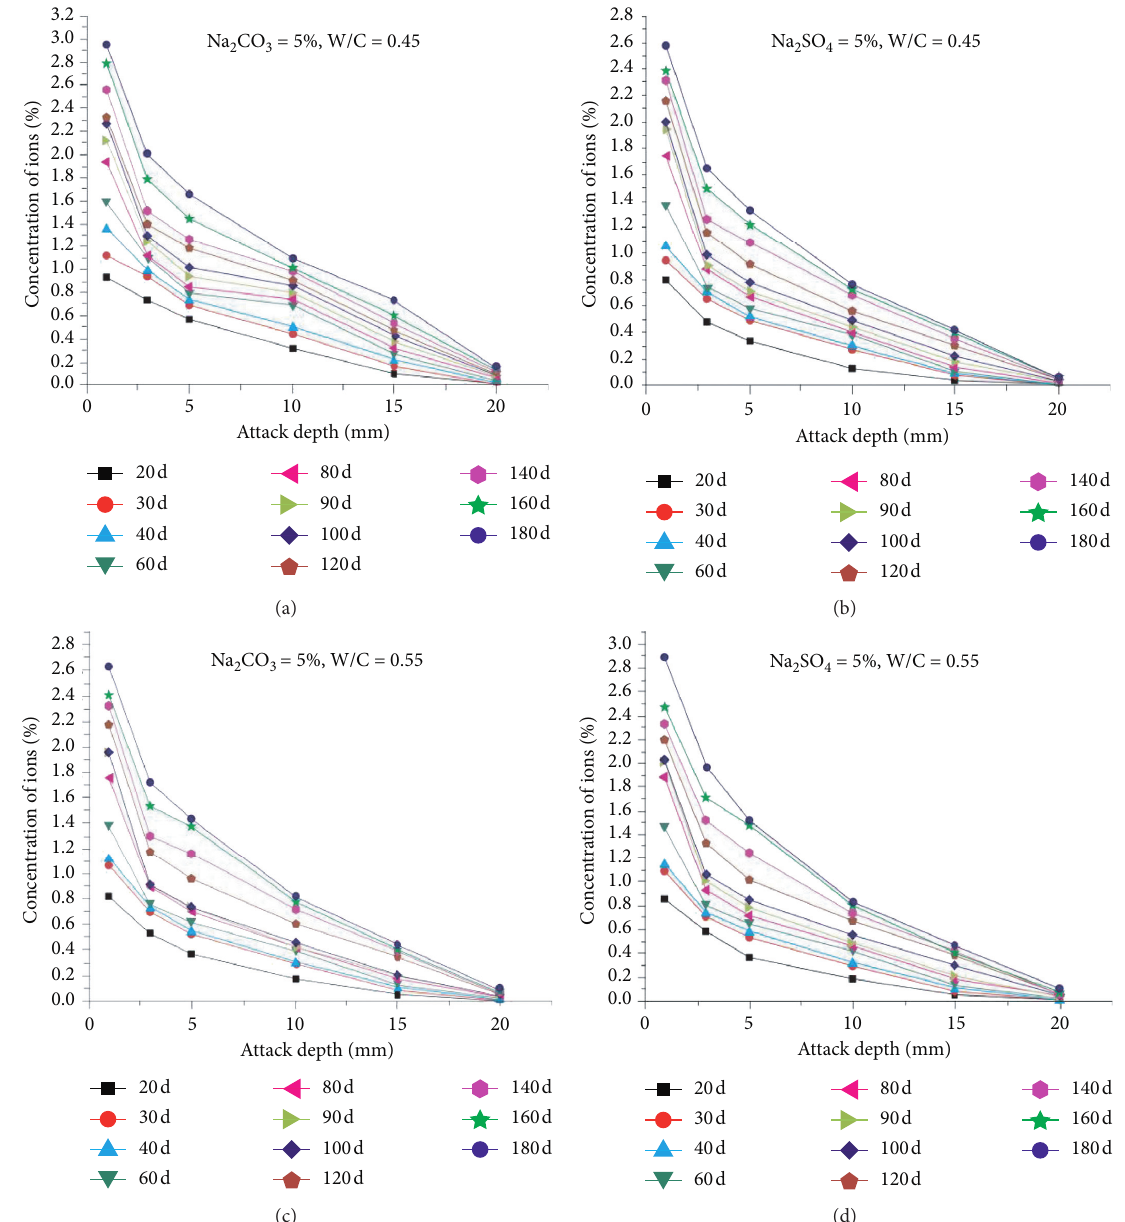
Figure 6: Relationship between the test results of ion content in different attack depths of concrete and varied cycles